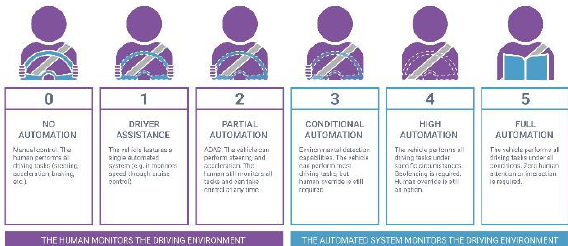
Figure 2. ©Levels of driving automation Copyright